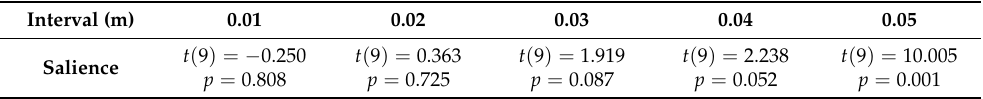
Table 16. Significant differences in the task completion time at different relative position depth distance intervals.